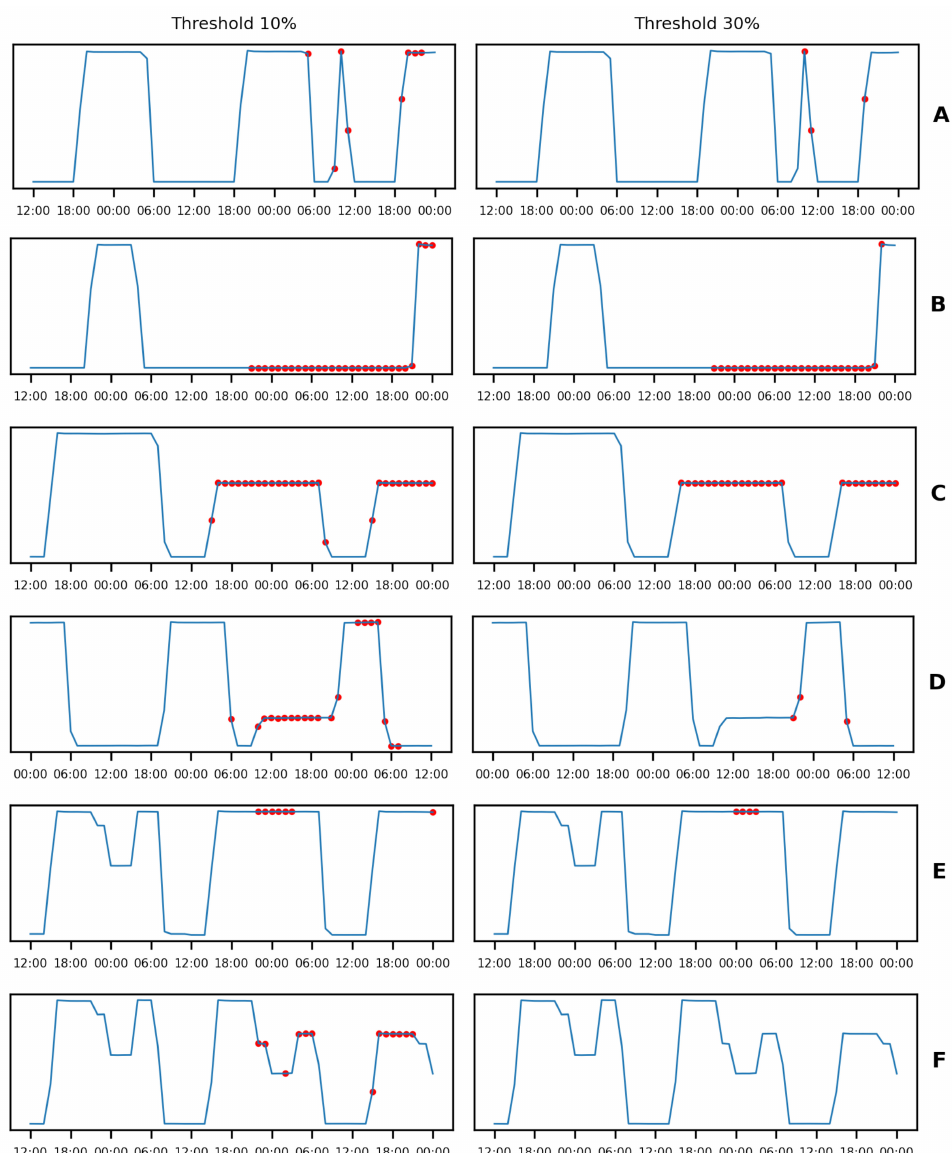
Figure 17. Application of different thresholds for anomaly detection for the LSTM algorithm. Subfigures ( A – F ) correspond to anomalies discussed in Section 3. Red circles indicate measurements for which the threshold has been exceeded (in 10% or